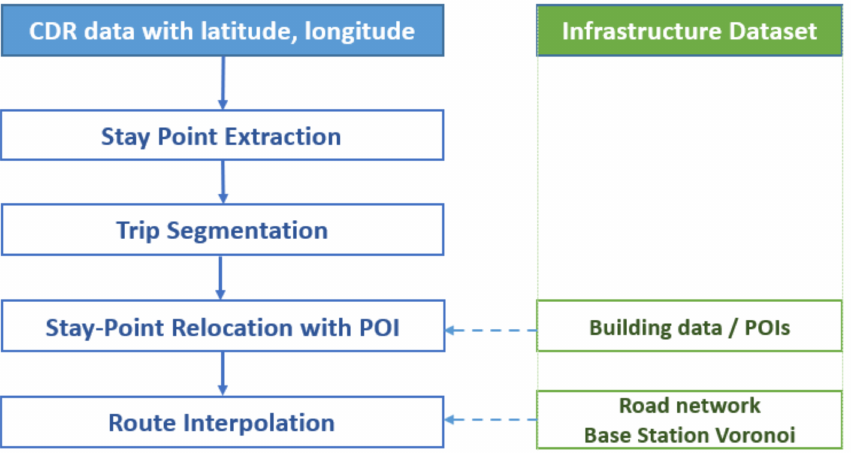
Figure 7. Overall steps of route